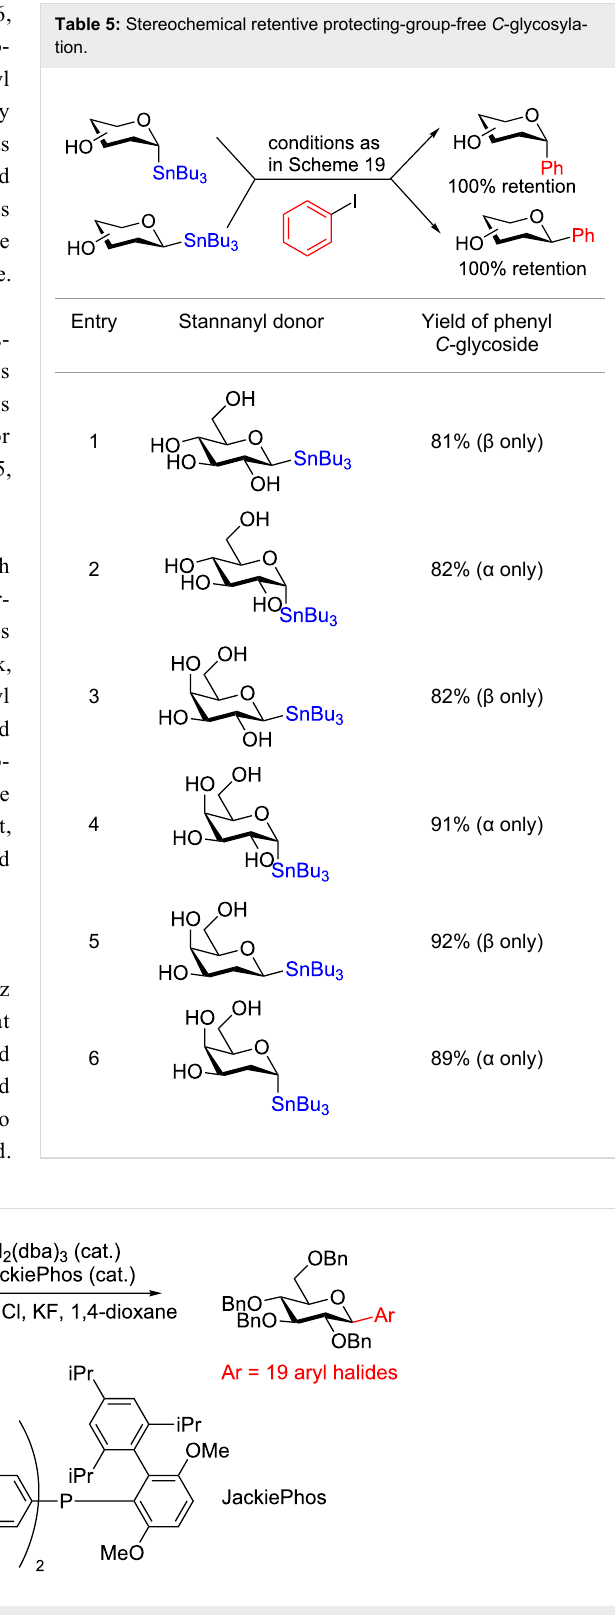
Scheme 19: The Pd-catalyzed stereoretentive glycosylation of arenes using anomeric stannane